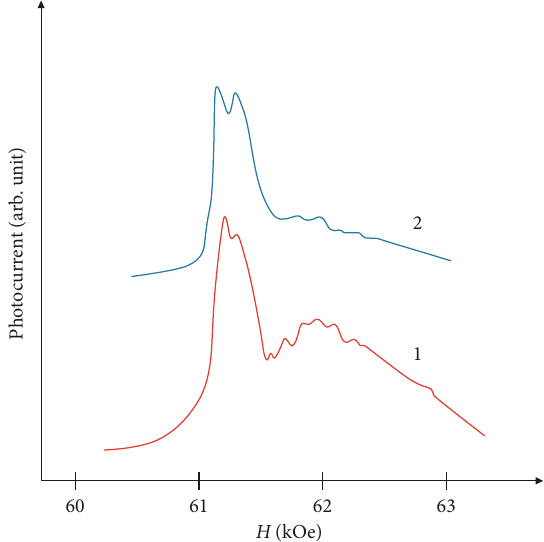
Figure 19: Structure of the CR line of the sample 6 at λ and T 4 . 2K. (1) ε 1V/cm without an illumination of the (cid:29) (cid:29) sample, and (2) ε 1V/cm under illumination in the region of (cid:29) fundamental